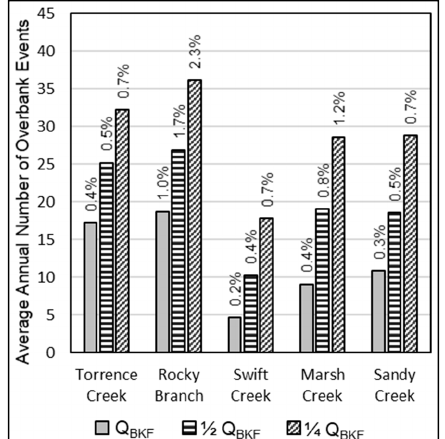
Figure 7. Average annual number of overbank events as a function of channel size. The percentages shown correspond to the total N retention/removal based on 20% treatment efficiency and 30 cm treatment depth.